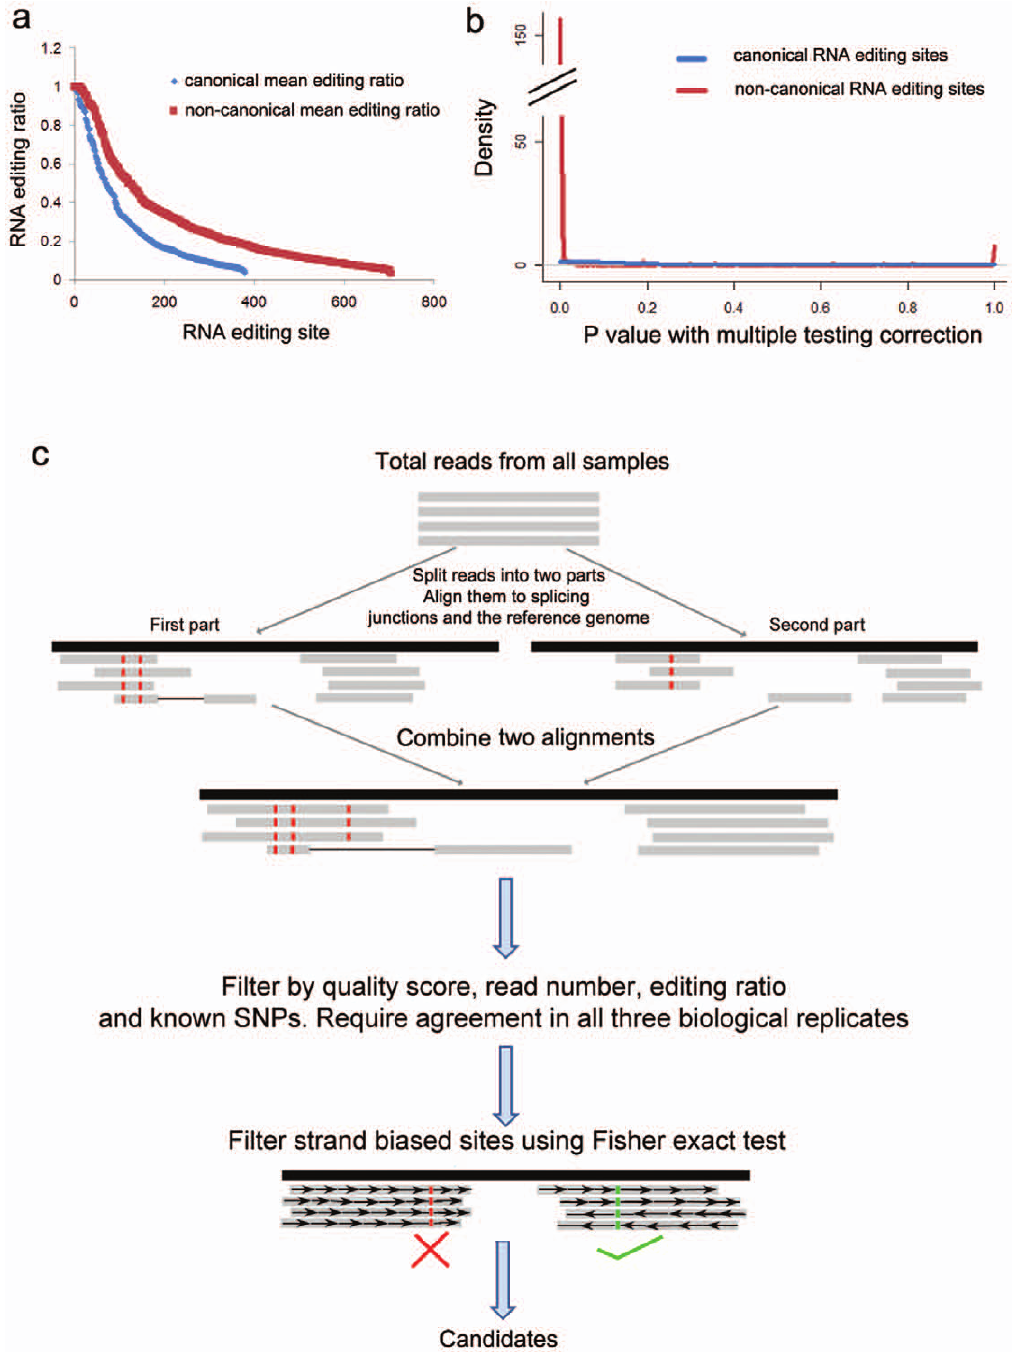
Figure 2. Identification of high-confidence RNA editing sites. A) Distribution of editing ratio for all observed canonical and non-canonical RNA editing sites in our adipose RNA-seq data shows that the ratio is higher for non-canonical than canonical sites. B) Distribution of Fisher’s exact test p-values for strand bias. Non-canonical RNA editing sites shows an extreme peak around zero, indicating that most non-canonical RNA editing sites are supported by strand biased reads. C) Overview of our RNA editing analysis